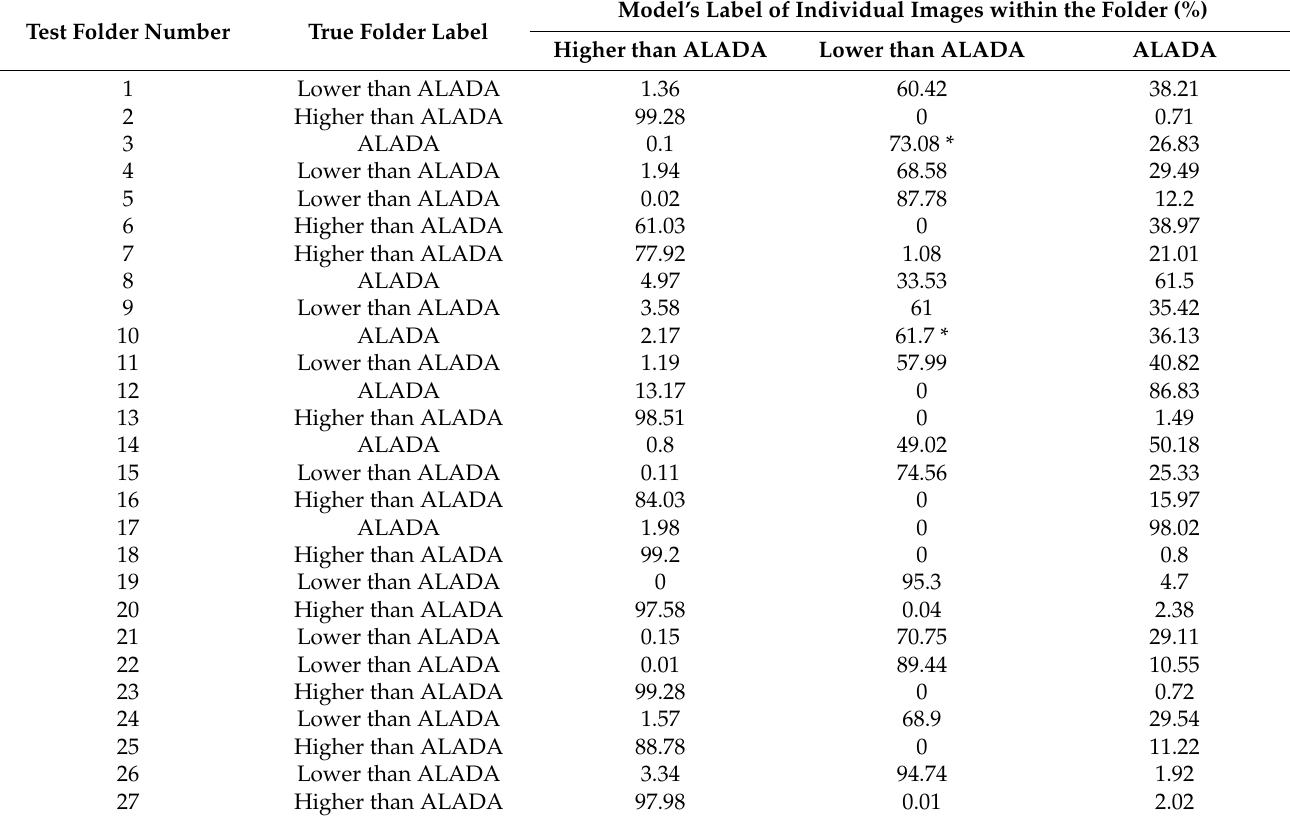
Table A1. Model 3DM1 (cid:48) s designation of the dose levels (labels) of the individual image sections within the test MDCT dataset folders. ALADA: as low as diagnostically